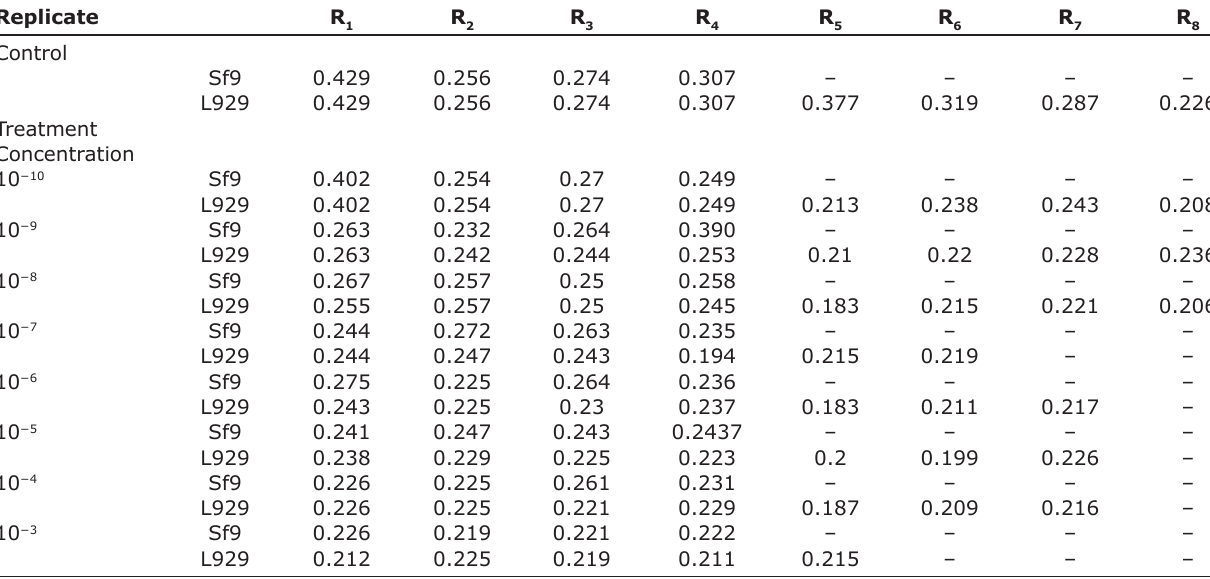
Table-2: Cytotoxicity of propoxur (μg/μL) against invertebrate (Sf9) and vertebrate (L929) cell lines.